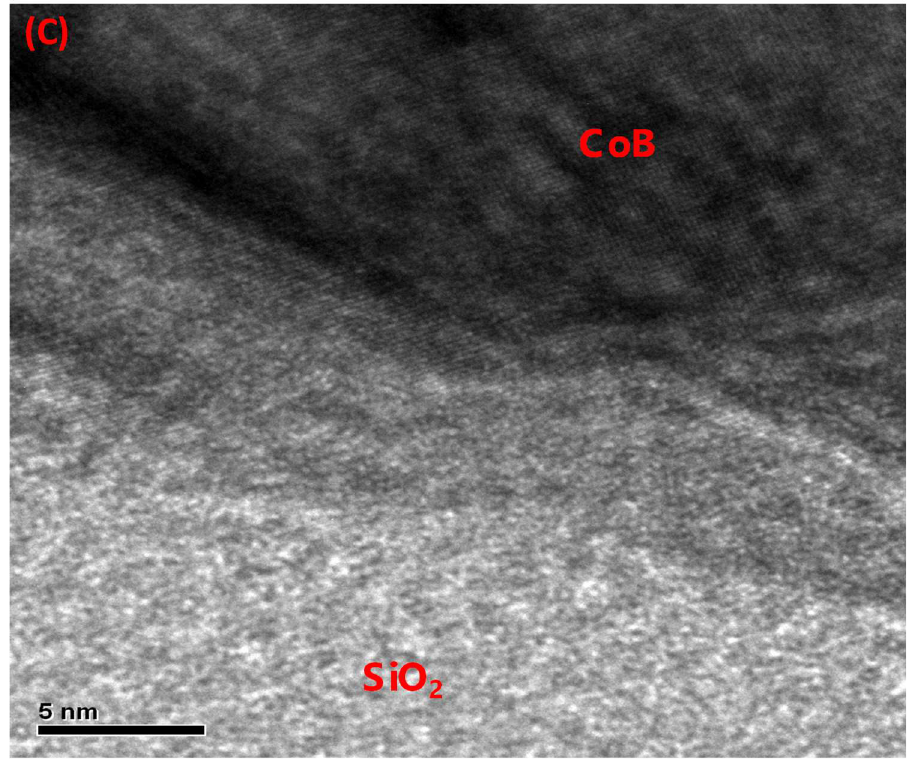
Figure 2. Cross-sectional TEM images: ( a ) as-deposited CuW/SiO 2 /Si; ( b ) annealed CuW/SiO 2 /Si; ( c ) annealed CuB/SiO 2 /Si.